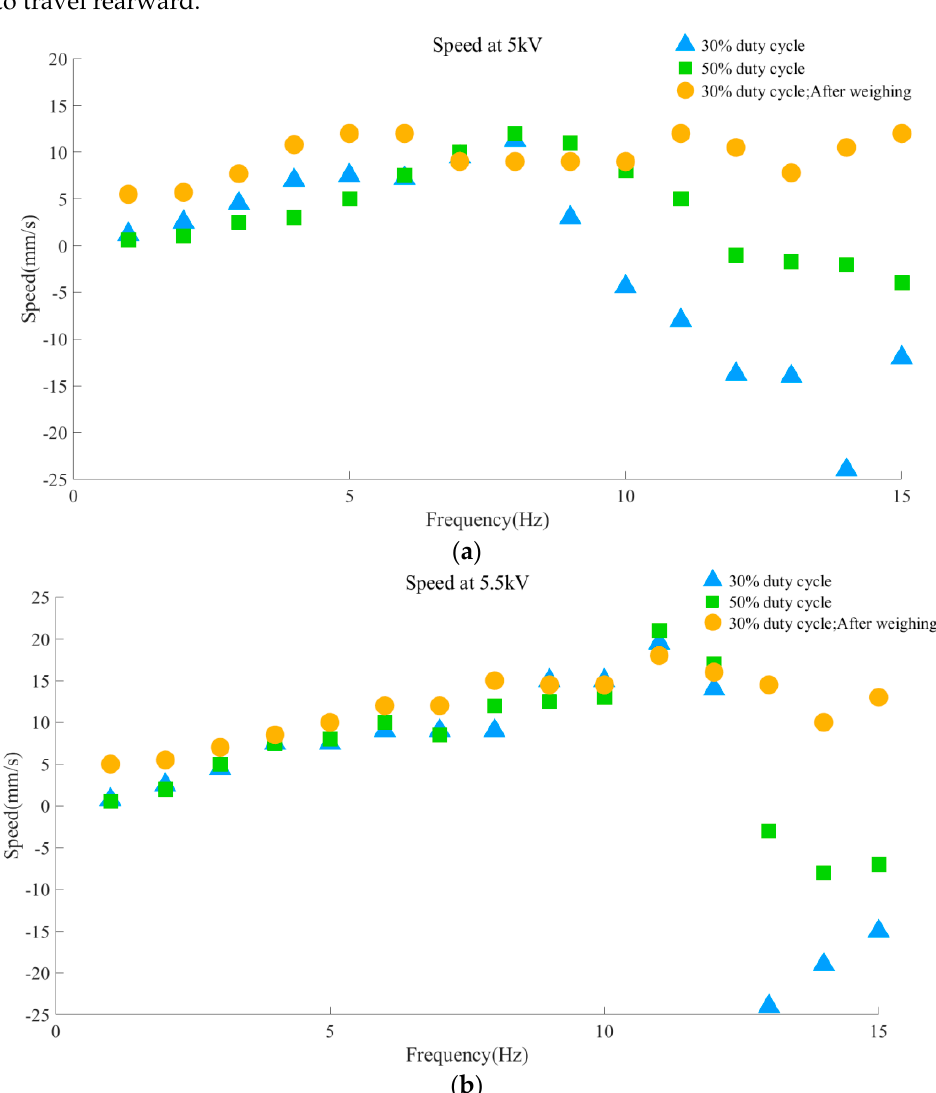
Figure 10. Contrast experiments. ( a ) Speed comparison of different duty cycle and weight of arc bottom at 5 kV; ( b ) Speed comparison of various duty cycles and weights of arc bottom at 5.5